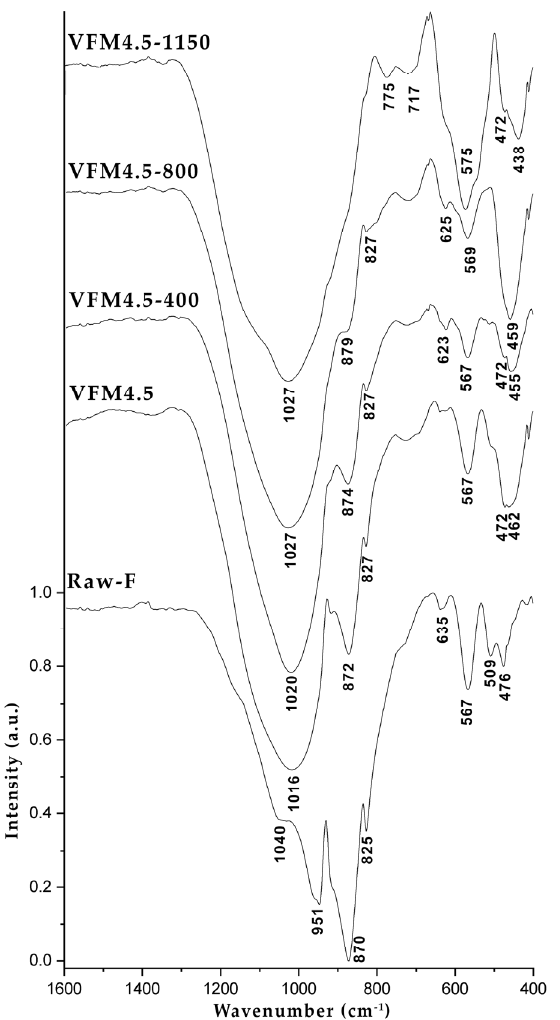
Figure 7. FTIR curves of raw fayalite, geopolymer series VFM4.5 and heat treated geopolymer at 400, 800 and 1150 °C.